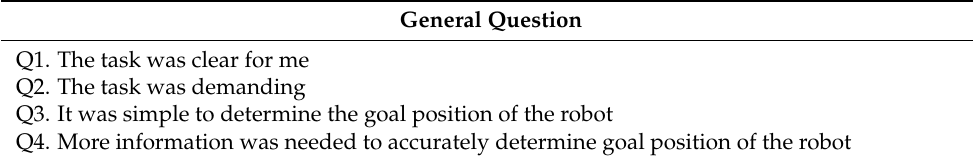
Table 2. General questions for all the tested